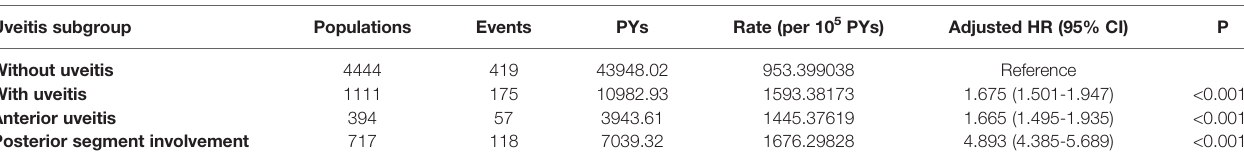
TABLE 4 | Factors of ACS among different uveitis subgroup using Cox regression with Fine & Gray ’ s competing risk model. Uveitis subgroup